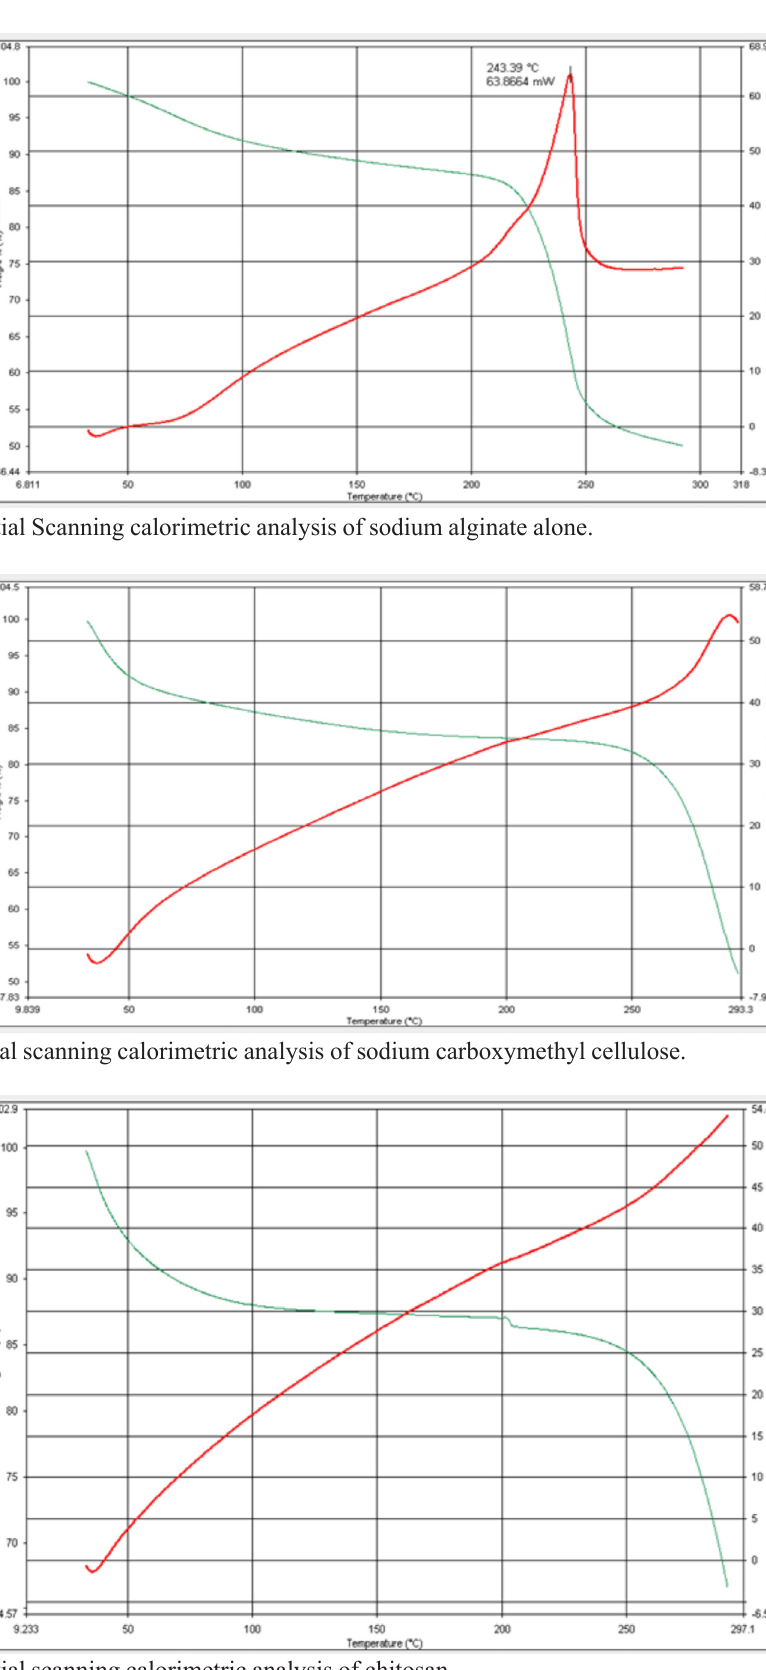
FIGURE 8 (d) - Differential scanning calorimetric analysis of chitosan.